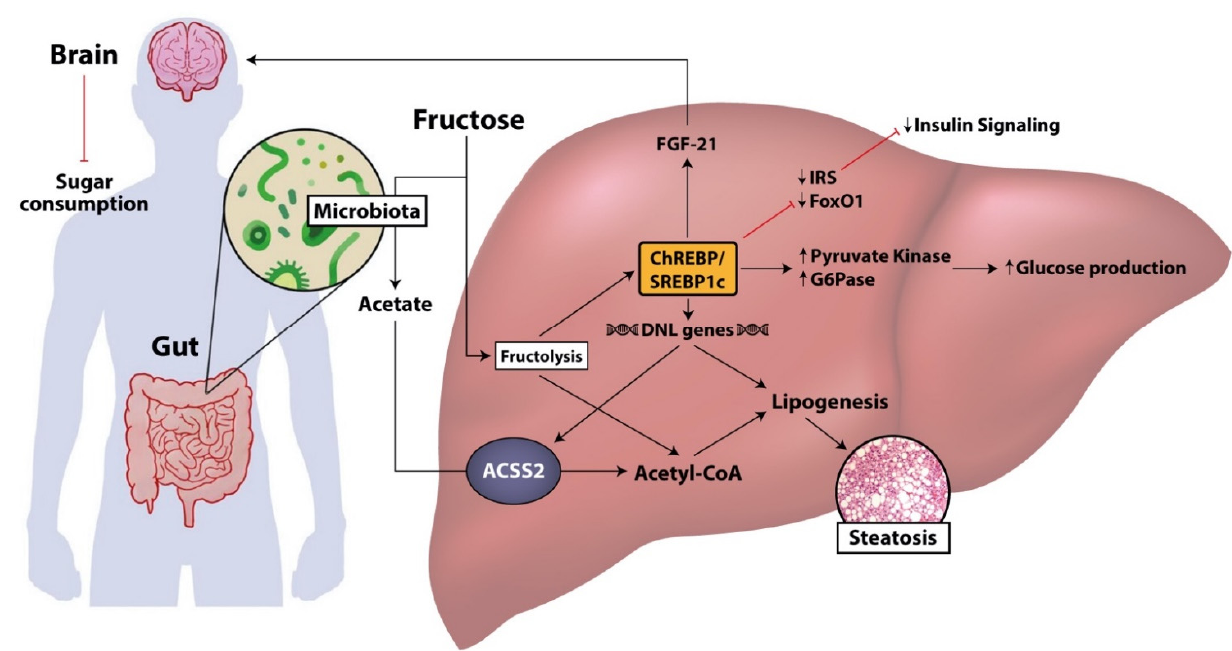
Figure 2. Fructose pathway involved in lipogenesis and insulin resistance. In the liver, fructose is metabolized as pyruvate via fructolysis, generating citrate and, successively, acetyl-CoA for lipogenesis. Dietary fructose is also converted by gut microbiota into acetate that is converted in acetyl-CoA by ACSS2 supplying the de novo lipogenesis. Fructose may directly activate SREBP1c and ChREBP, potent inducers of DNL genes such as ACSS2, contributing to the development of steatosis. ChREBP is active also on glucose production, inducing metabolic gene expression such as pyruvate kinase and glucose-6-phosphate, resulting in an increased gluconeogenesis. Furthermore, high fructose diet may reduce the expression of IRS and FoxO1, resulting in an inhibition of insulin signaling and an increased plasma glucose expression. On the contrary, as a compensatory mechanism, ChREBP activates the expression of several enzymes and hormones that modulate the sugar consumption, suppressing the sweet taste preference. ACSS2, Acetyl-CoA synthetase short-chain family member 2; ChREBP, carbohydrate-responsive element-binding protein; DNL, de novo lipogenesis; FGF-21, fibroblast growth factor—21; FoxO1, forkhead box O1; IRS, insulin receptor substrate; SREBP1c, sterol regulatory element-binding protein 1c.